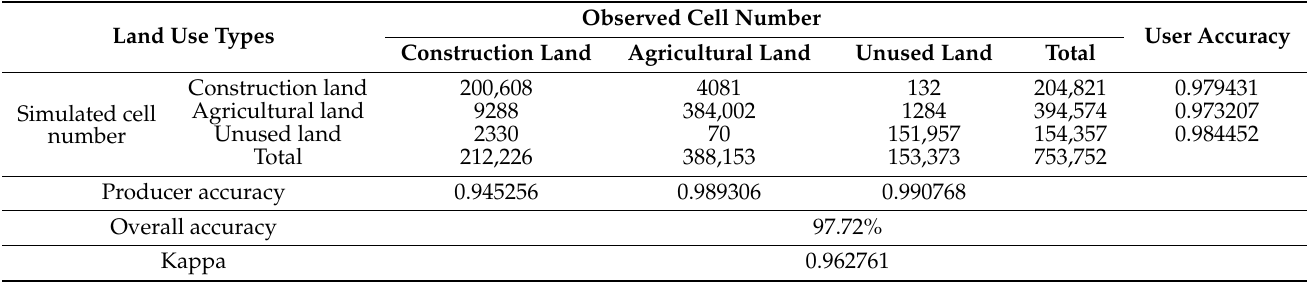
Table 6. The confusion matrix of observed and simulated land use types in 2020.